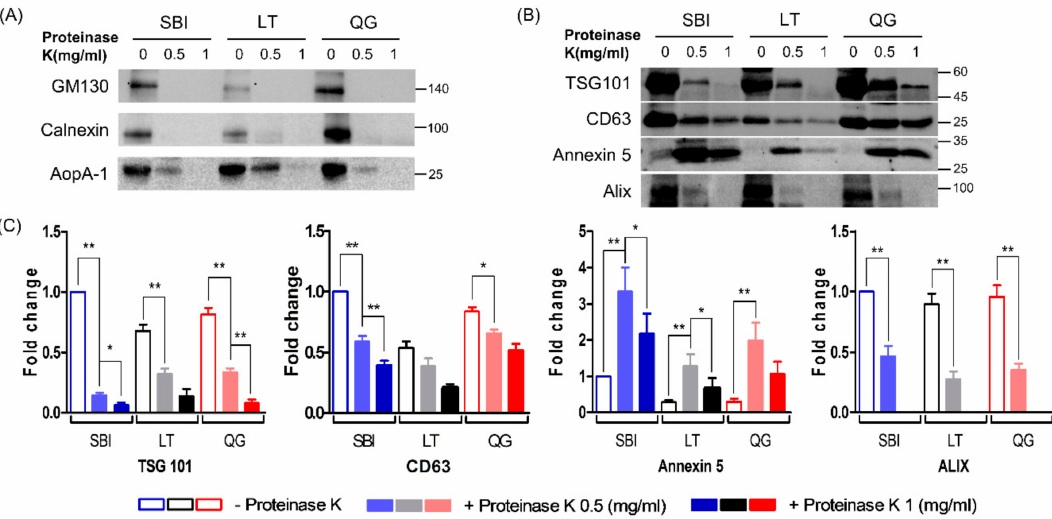
Figure 2. Western blot analyses of exosomal and non-exosomal proteins in ELV preparations using three kits with or without treatment of proteinase K. ( A ) Comparison of the expression levels of non-exosomal markers (GM130, calnexin, ApoA-1) in ELVs prepared by three kits. ELVs prepared without proteinase K showed the abundant expression of contaminated non-exosomal component, which was drastically decreased by treatment of proteinase K. A representative blot was shown (n = 6). ( B ) Expression of exosomal markers (TSG101, CD63, annexin 5, and Alix) in ELVs prepared by three kits with or without treatment of proteinase K. ( C ) Quantification of the expression levels of TSG101, CD63, annexin 5, and Alix in each ELV preparation showed that the levels of TSG101, CD63, and Alix were decreased by proteinase K treatment in a dose-dependent manner, while the level of annexin 5 was not (n = 6). * p < 0.05, ** p < 0.01 by Mann–Whitney U test. SBI, ExoQuick Exosome Isolation Kit for Serum and Plasma; LT, Invitrogen ™ Total Exosome Isolation Kit; QG kit, miRCURY Exosome Serum / Plasma